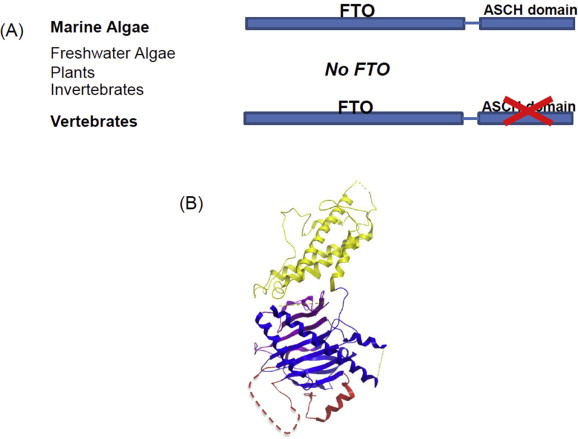
(A) FTO homologues exist in vertebrate and in marine algae but only in the algae it has an additional ASCH domain at the C’-terminus. (B) FTO binds to TRIP4 through two surface mobile epitopes (red) exposed at one side of FTO as visualised here in the 3-dimentional structure. Dashed lines indicate mobile loops invisible in the crystal structure and the structure is coloured according to structural units as in Figure 6C.